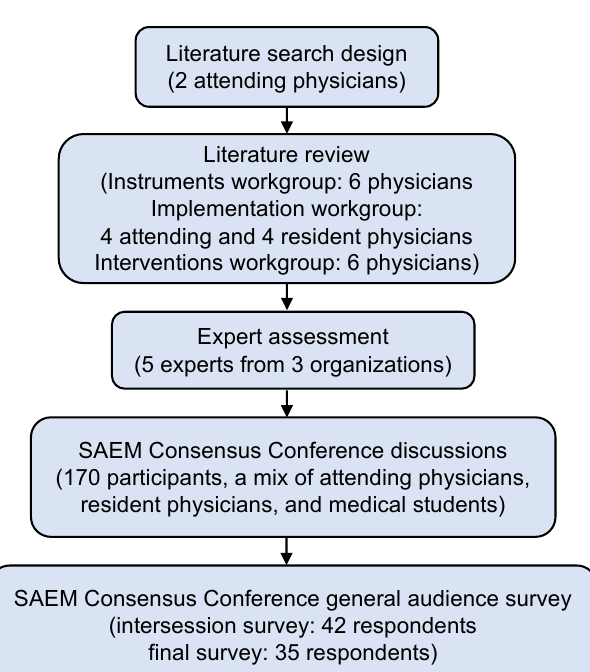
Figure 1. 2021 Society of Academic Emergency Medicine (SAEM) Consensus Conference process for identifying research gaps and priorities for implementation of emergency department-based social risks and needs